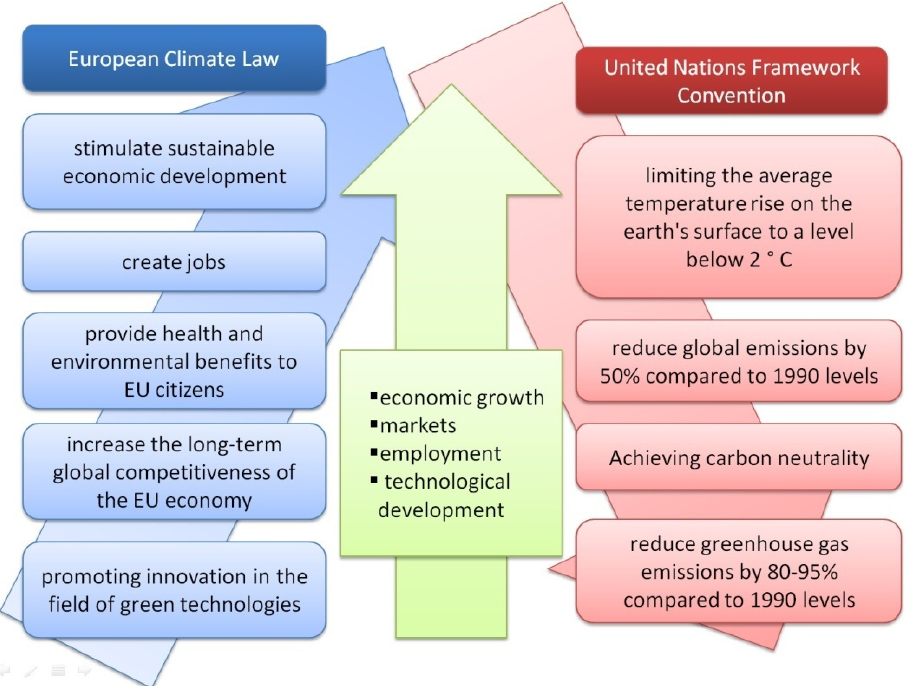
Figure 28. Capabilities of stopping climate change [66–69].